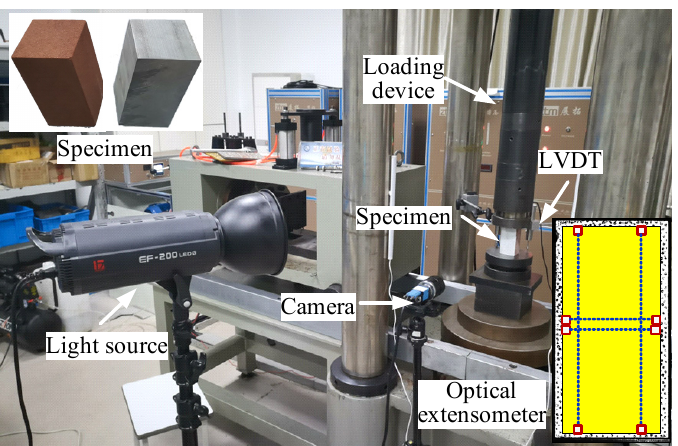
Figure 7. Testing system.